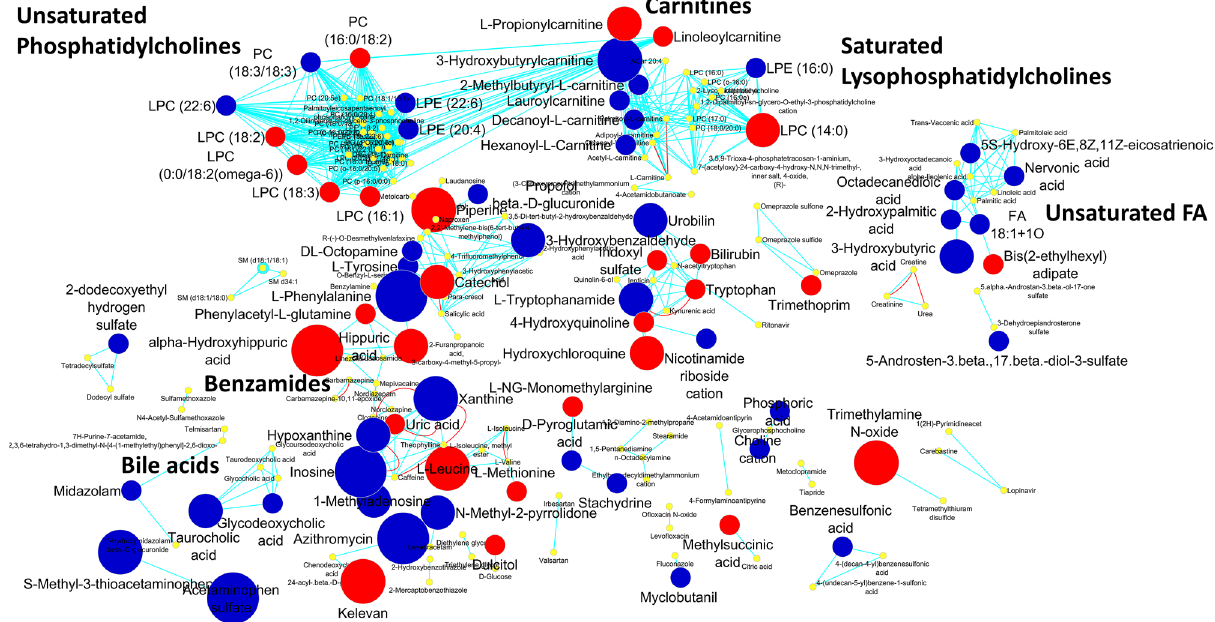
Figure 3. MetaMapp visualization of metabolomic data highlighting the differential metabolic regulation in mild disease COVID-19 positive patients at hospital discharge compared to the same patients at hospital admission. Red edges denote KEGG reactant pair links and light blue edges symbolize Tanimoto chemical similarity at T > 700. Node sizes reflect fold change. Metabolites found significantly increased are given as